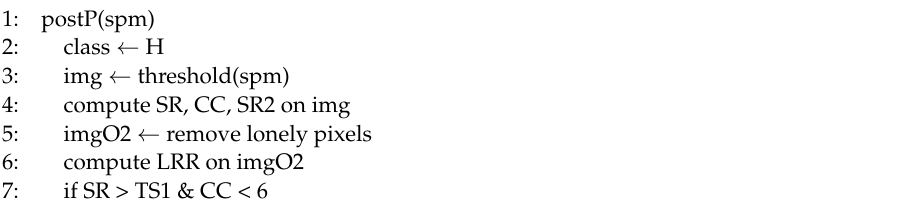
Algorithm 1 Pseudocode of the learned postprocessing